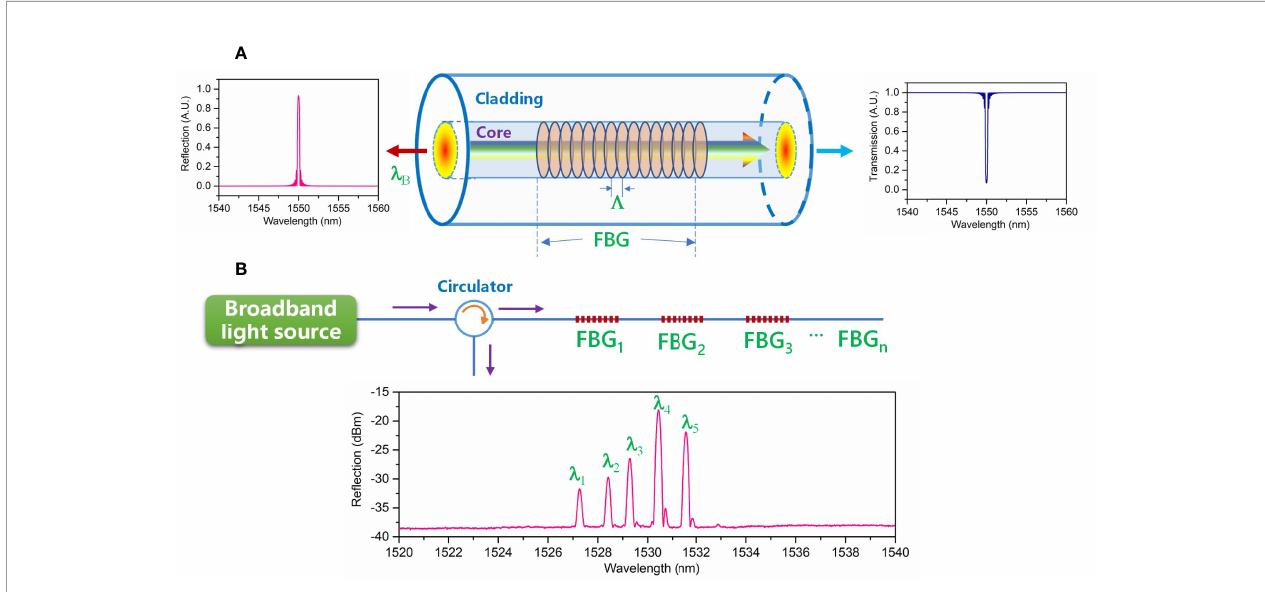
FIGURE 1 | Schematic illustration of (A) working principle of the optical fi ber Bragg grating (FBG) and (B) multiplexing principle of various FBG-based